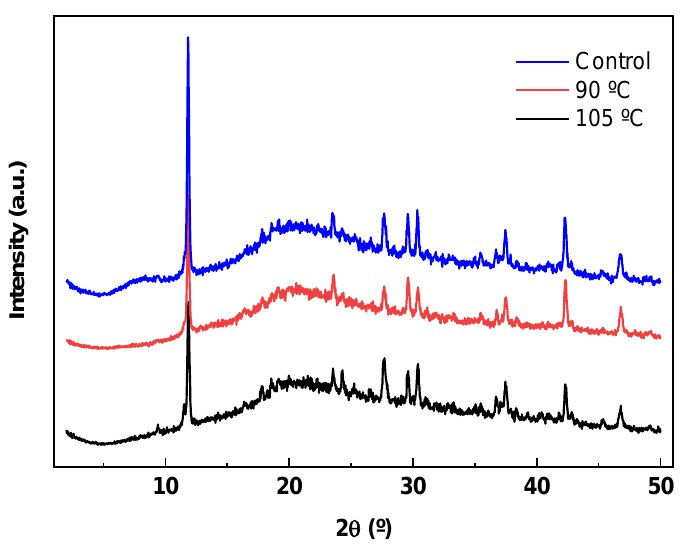
Figure 5. XRD patterns of control and thermally treated films.